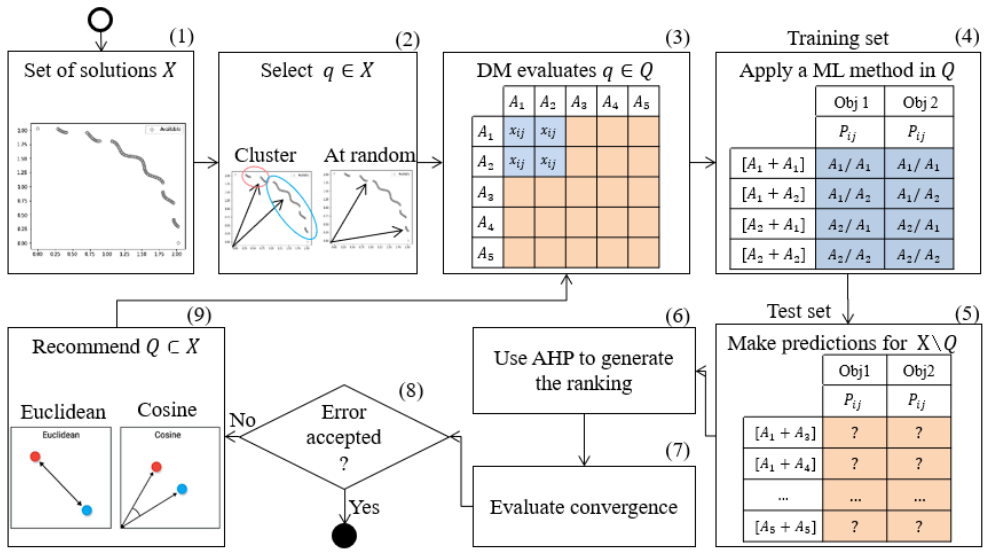
Figure 1. Flowchart illustrating the main steps of the proposed methodology to make the decision process with AHP